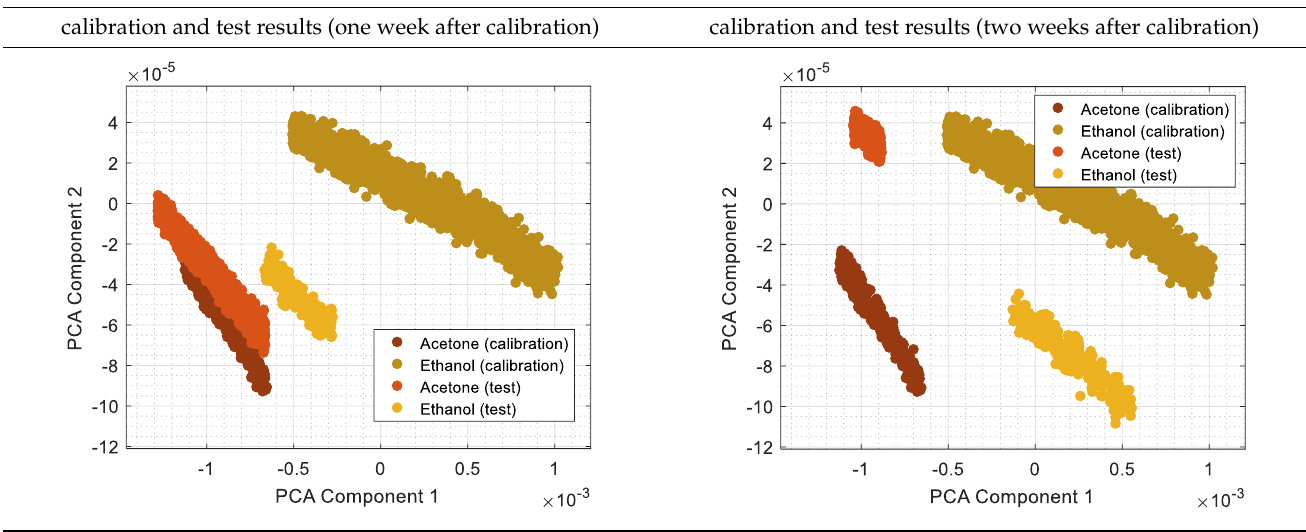
Table 1. Projection of the calibration data of ethanol and acetone using PCA. Comparative projection of new test data of ethanol and acetone obtained one week (left column) and two weeks (right column) after the calibration. Unpublished results from